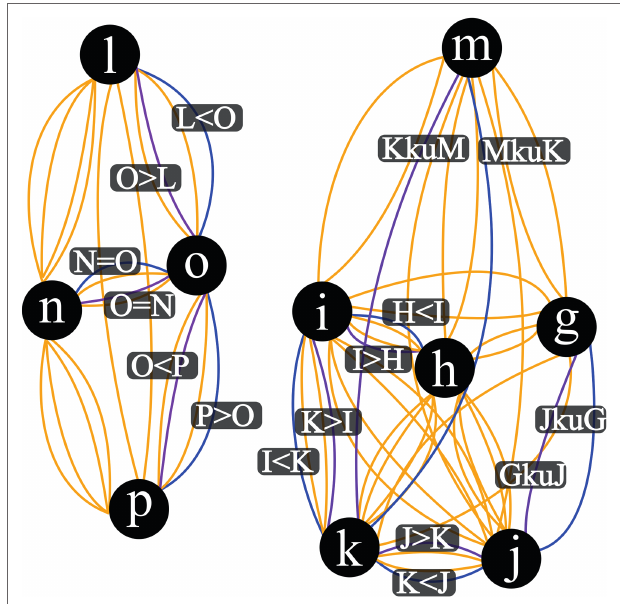
FIGURE 3 | Visualization Output for Complex Mixed Relation Network. This also illustrates how networks may be isolated from one another. Vertex represent stimuli, blue edges are input relations, purple edges are mutually derived relations, and orange edges are combinatorially derived relations. *Combinatorially derived relational labels omitted for publication